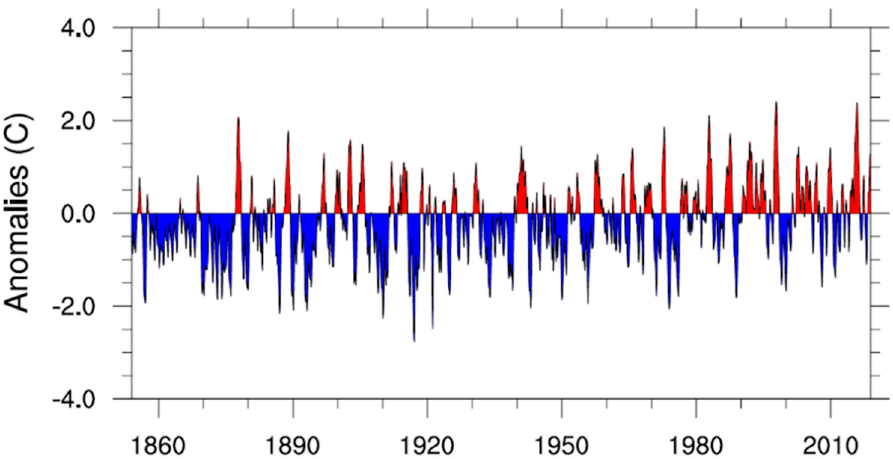
Figure 1. Oceanic Niño Index (ONI) calculated from NOAA Extended Reconstructed SST v4 from 1854 to 2018.